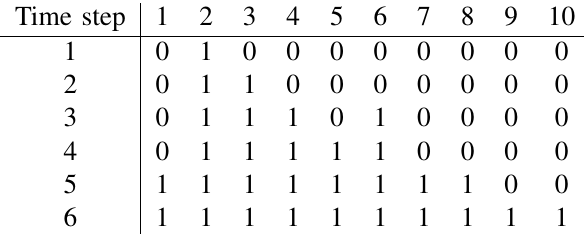
Fig. 9. Dynamics of fish school model with initial condition: fish 2 senses predator (time step 1).